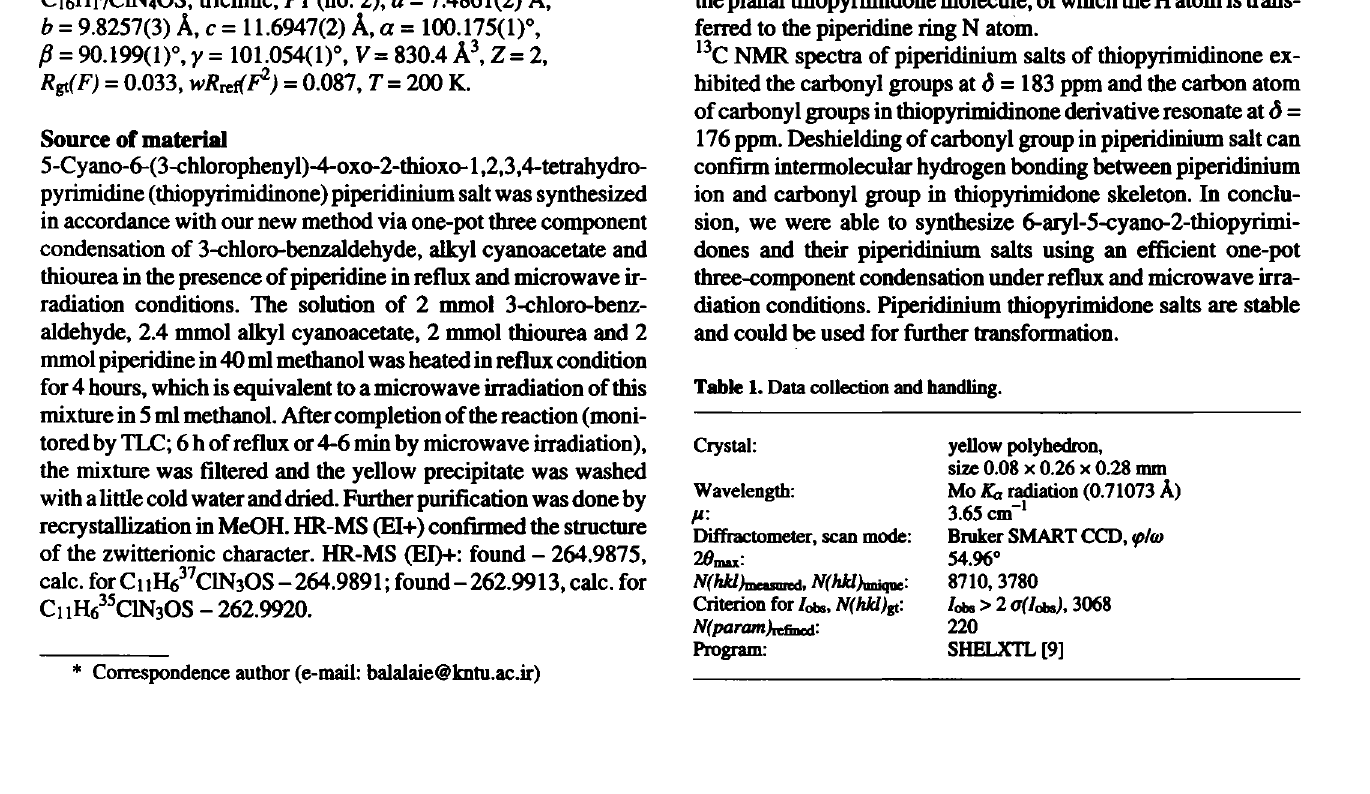
C16H17CIN4OS, triclinic, PI (no. 2), a = 7.4861(2) A, b = 9.8257(3) A, c = 11.6947(2) A, a = 100.175(1)°,